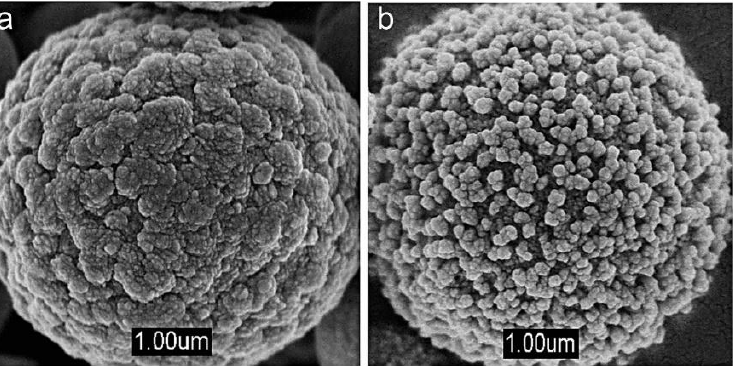
Figure 9. SEM images of bare ( a ) and Co-doped ( b ) ZnO. Obtained from reference [100].